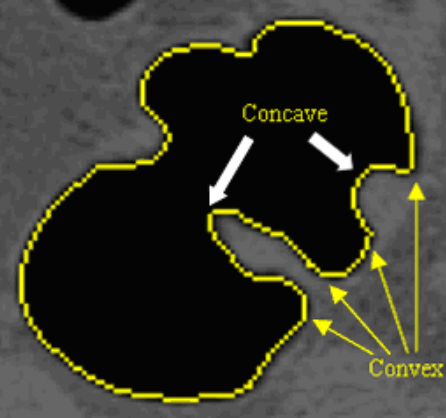
Figure 6. Convexity analysis along a 2D contour of the colon